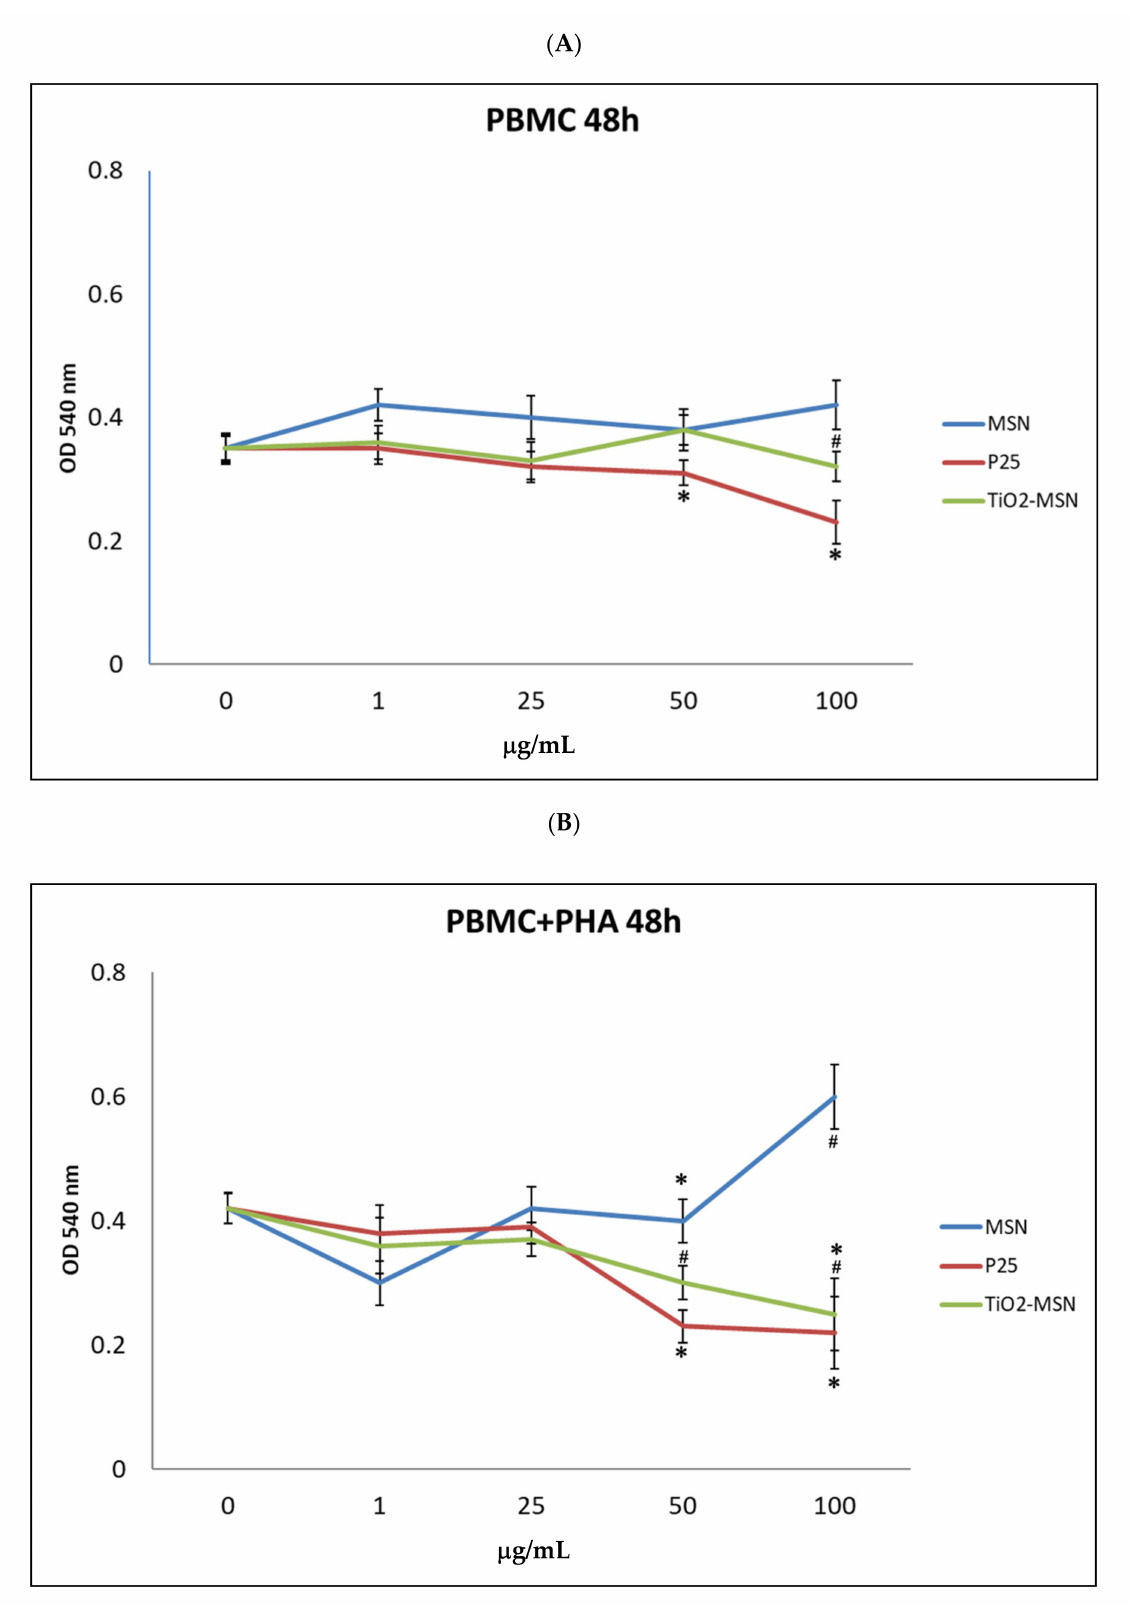
Figure 2. MTT (3-(4,5-dimethylthiazol-2)-2,5 diphenyl tetrazolium bromide) viability assay. ( A ) without phytohaemoagglu- tinin (PHA) and ( B ) with PHA. Significance values: * or # = p < 0.05; error bars represent the standard error of the